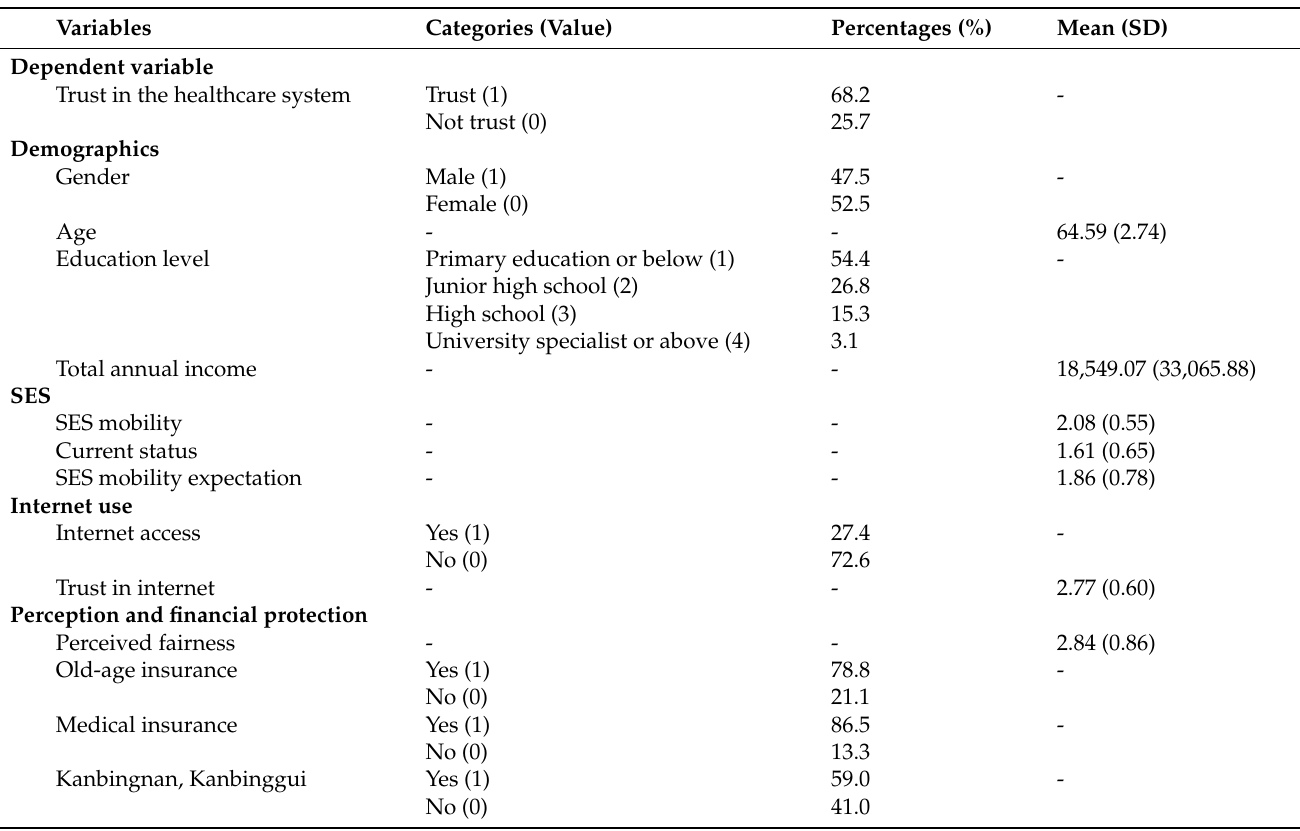
Table 1. Descriptive statistics of the variables of